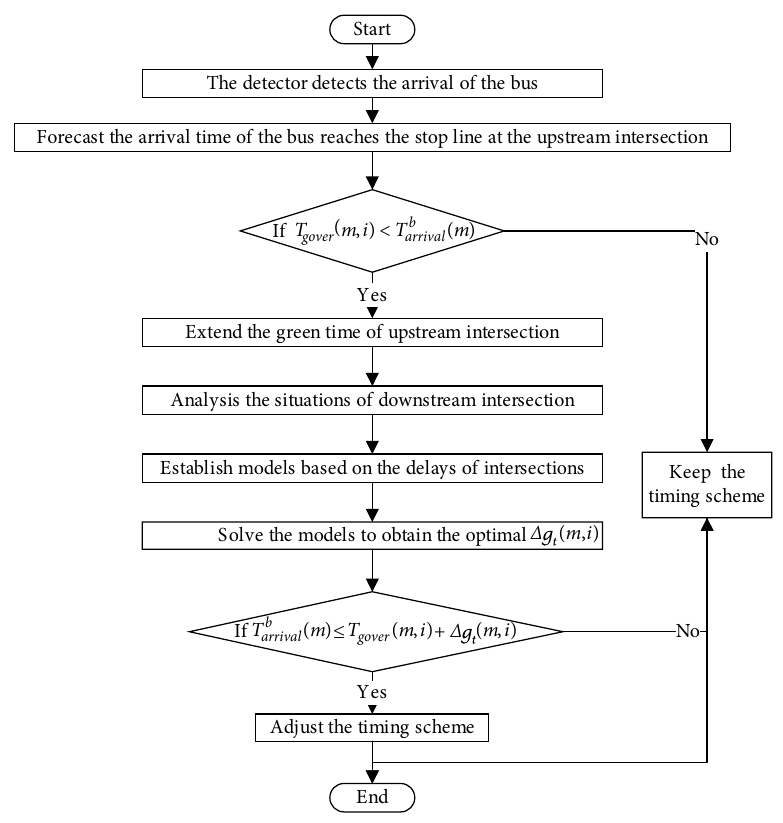
Figure 3: Flow chart of (2) The reduced delay of social vehicle users is shown in Figure 4. Social vehicles can pass the intersection with- out stopping in the extended green time Δ𝑔